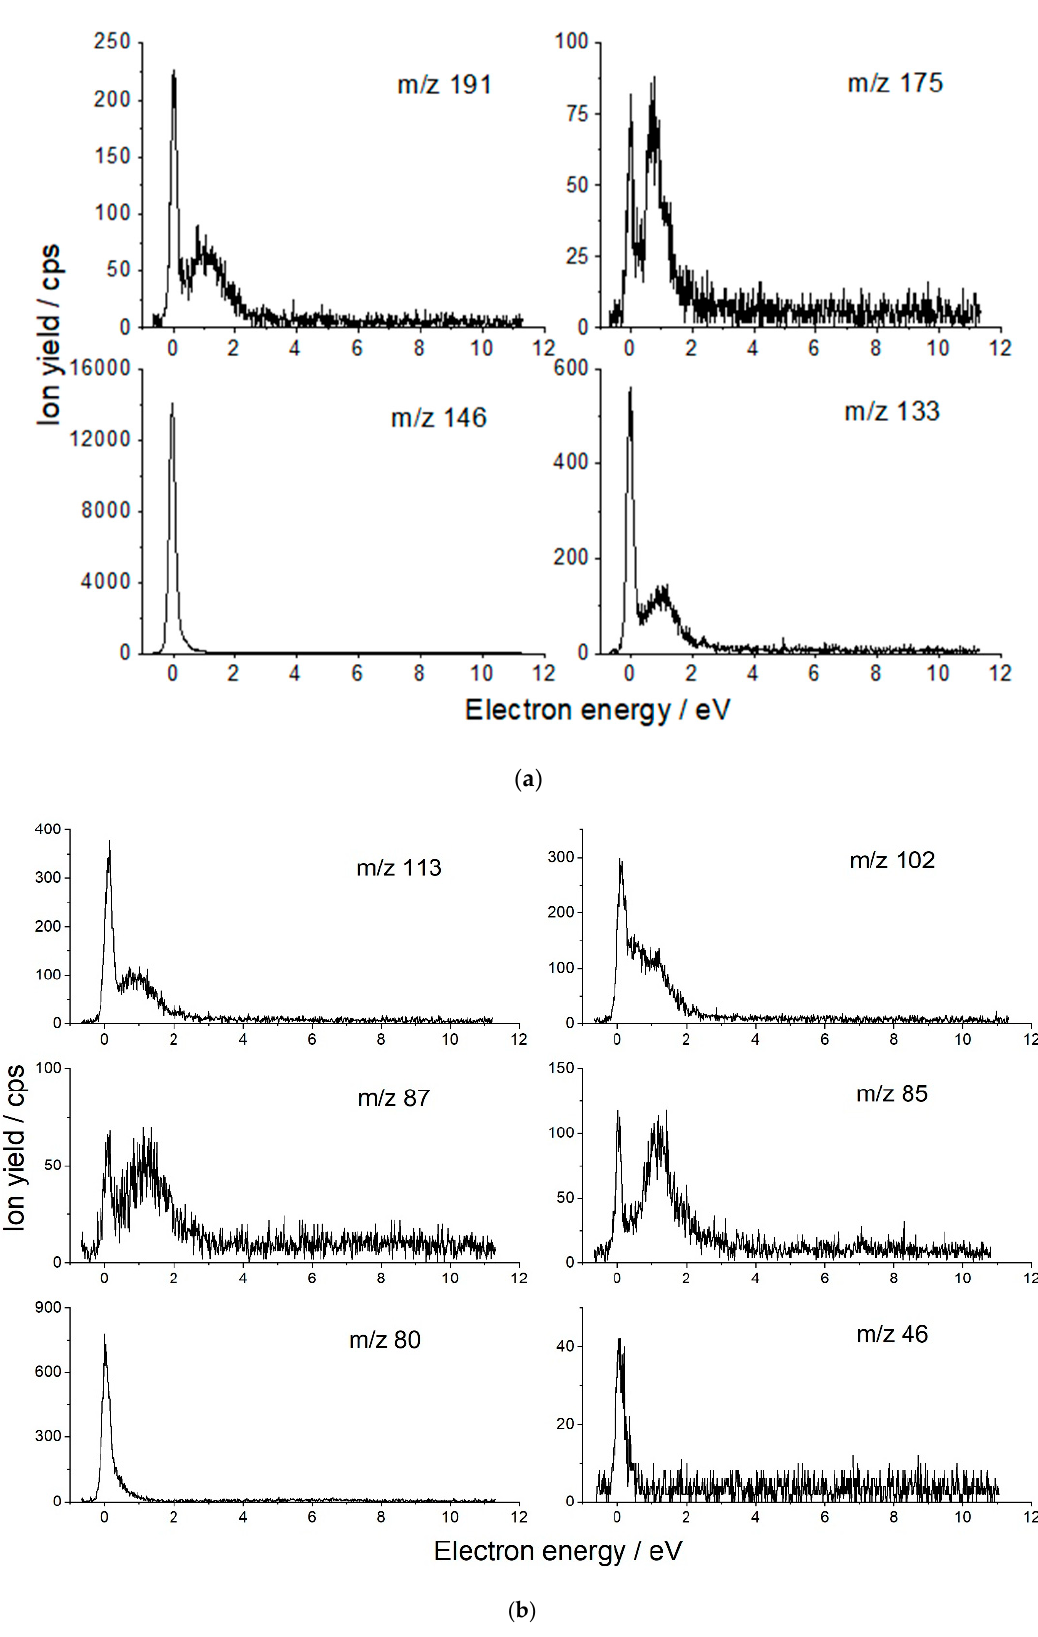
Figure 3. Anion yield functions of the citric acid: ( a ) fragment anions with m/z 191, 175, 146, and 133; ( b ) fragment anions with m/z 113, 102, 87, 85, 80 and 46.